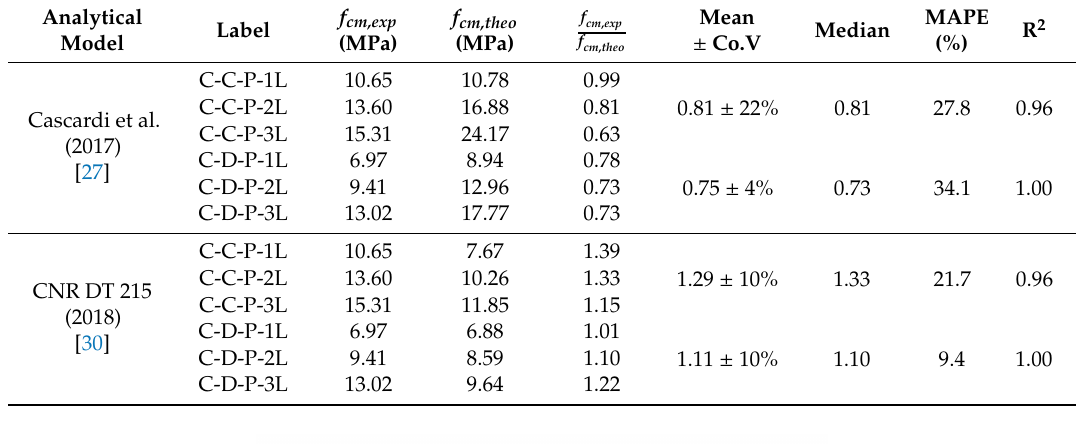
Table 4. Evaluation of the analytical models.